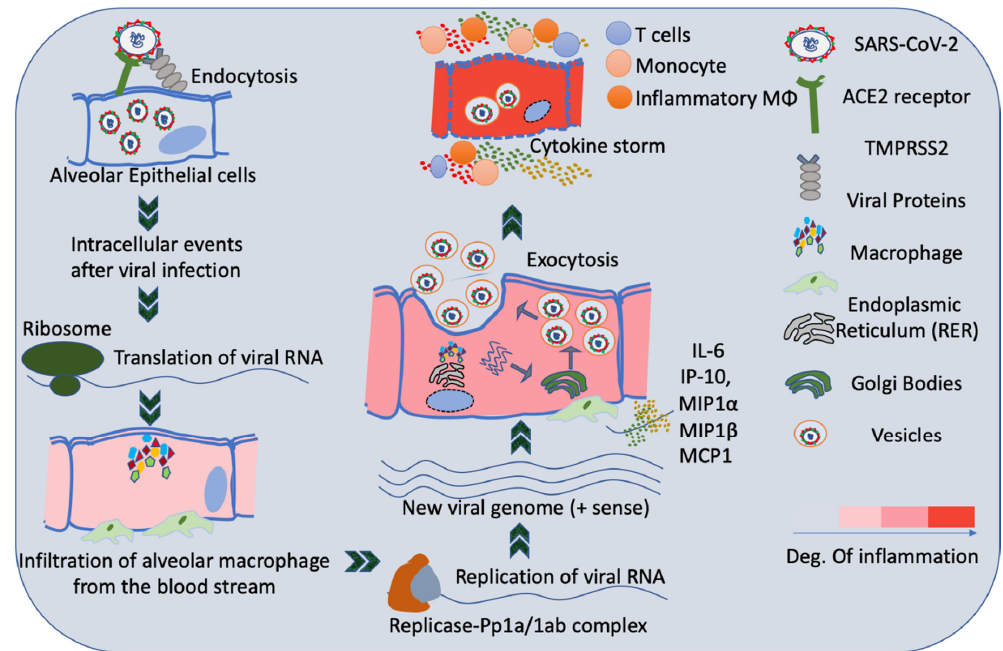
Figure 2. Schematic representation of sequential intracellular events in alveolar epithelial cells due to SARS-CoV-2 infection. SARS-CoV-2